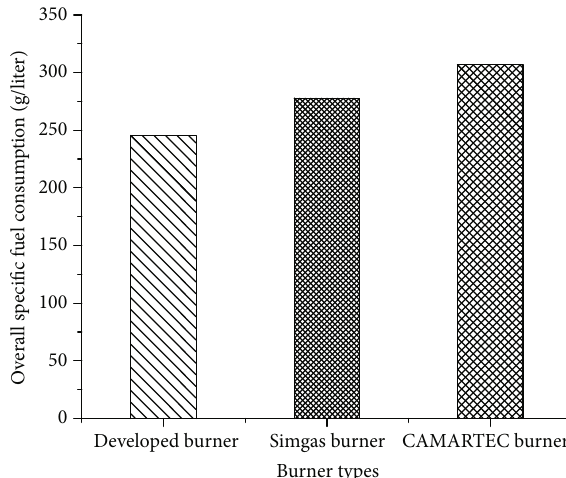
Figure 11: Overall speci fi c fuel consumption over the entire WBT for the three burners.